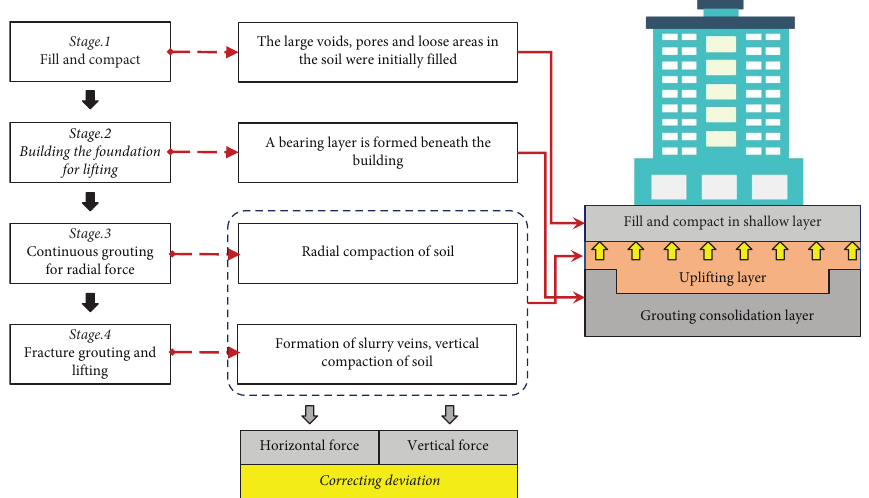
Figure 1: Flowchart of nondestructive controllable